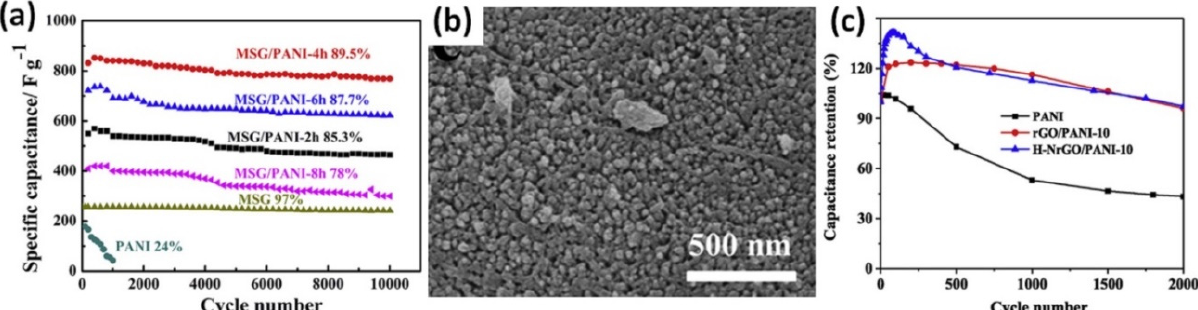
Figure 3. The cycling properties of samples at a current density of 10 A/g ( a ) and microstructure patterns of MSG/PANI after 4 h of polymerization ( b ) (Reprinted from [43], Copyright 2018, with permission from Elsevier). Cycling stability of the PANI, RGO/PANI-10 and H-NRGO/PANI-10 electrodes by cyclic voltammetry at 100 mV/s in H 2 SO 4 ( c ) (Reprinted from [59], Copyright 2019, with permission from